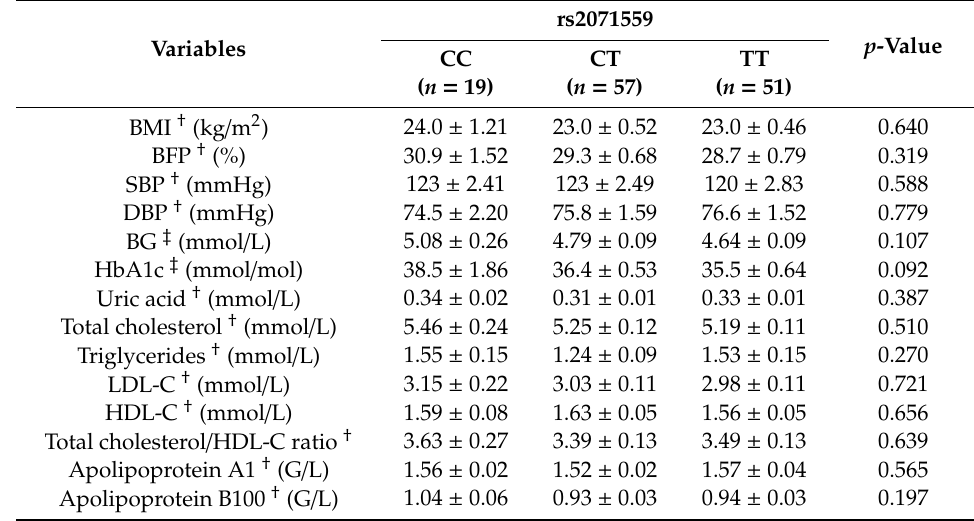
Table 3. Values of cardiometabolic risk parameters according to genotype of VEGFR-2 gene rs2071559 SNP ( n =